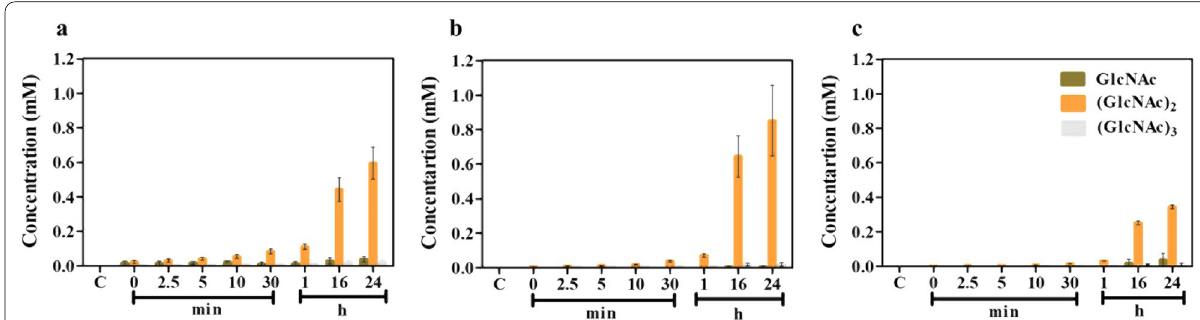
Fig. 4 Quantitative analysis of hydrolysis products by HPLC. Substrates were a squid pen, b shrimp shell and c crab shell chitin, shown as bar graphs of concentration against the reaction time. Concentrations were estimated from the corresponding standard calibration curve, for the three main hydrolytic products GlcNAc, (GlcNAc) 2 and (GlcNAc) 3 ). The control (C) contained the substrate but no enzyme. Values are means